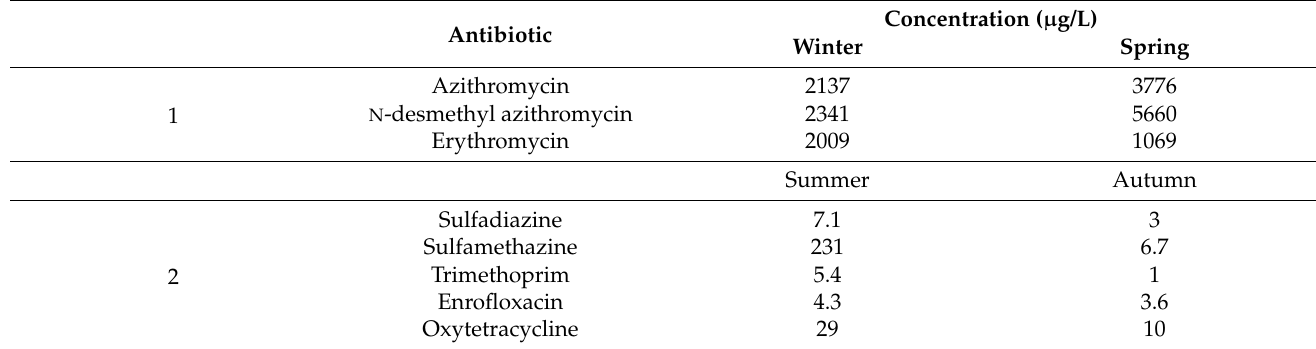
Table 3. Macrolides concentrations measured in effluents of Company 1 and the concentrations of Figure 3. during four seasons